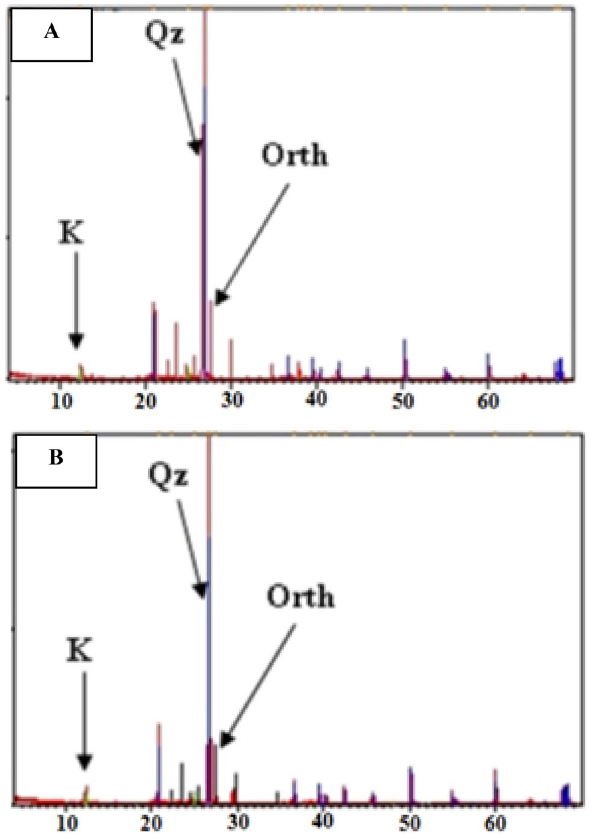
Fig. 4 XRD graph displays bulk mineral composition of sandstone samples. a S#8, group (A), ϕ = 29.9%, K = 149mD. b : S#3, group (B), ϕ = 29.3%, K = 3578